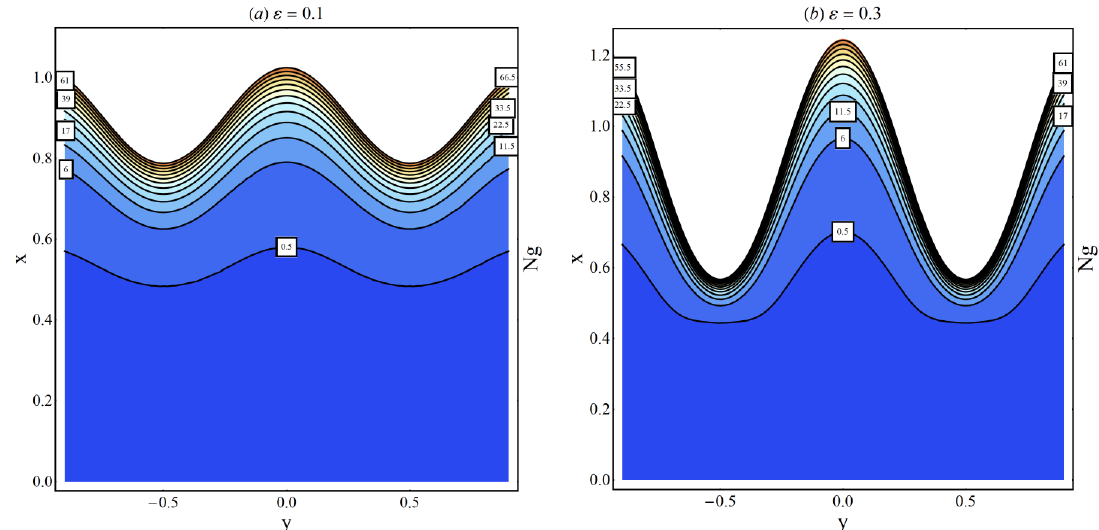
Figure 14. Entropy lines at two different values of ε : (a) ε = 0.1 and (b) ε = 0.3